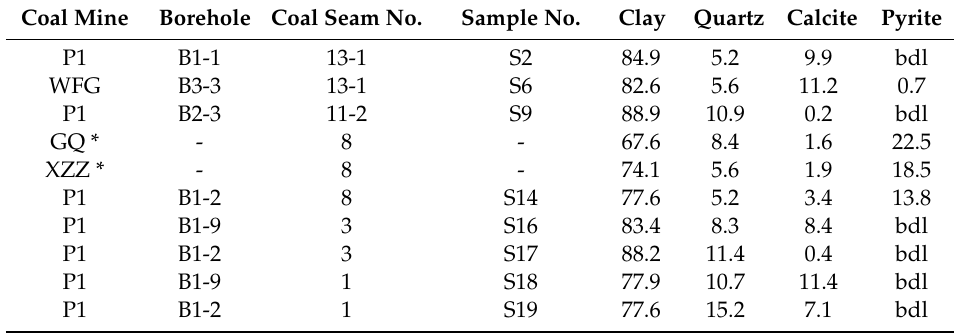
Table 3. Mineralogical composition of raw coal samples (%) determined by X-ray diffraction. Coal Mine Borehole Coal Seam No. Sample No. Clay Quartz Calcite Pyrite B1-1 13-1 S2 84.9 5.2 9.9 bdl 13-1